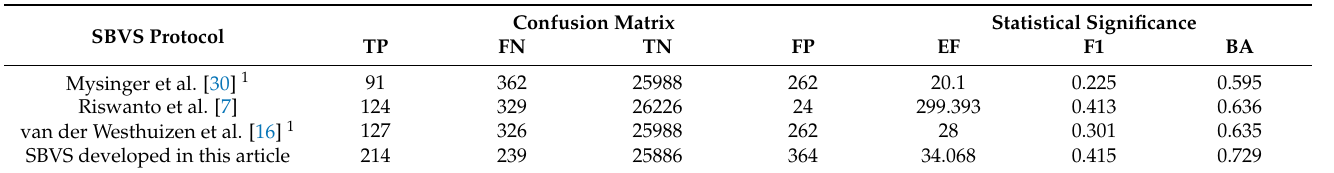
Table 2. Prediction abilities of some SBVS protocols to identify AChE inhibitors using ligand and decoys from DUD-E